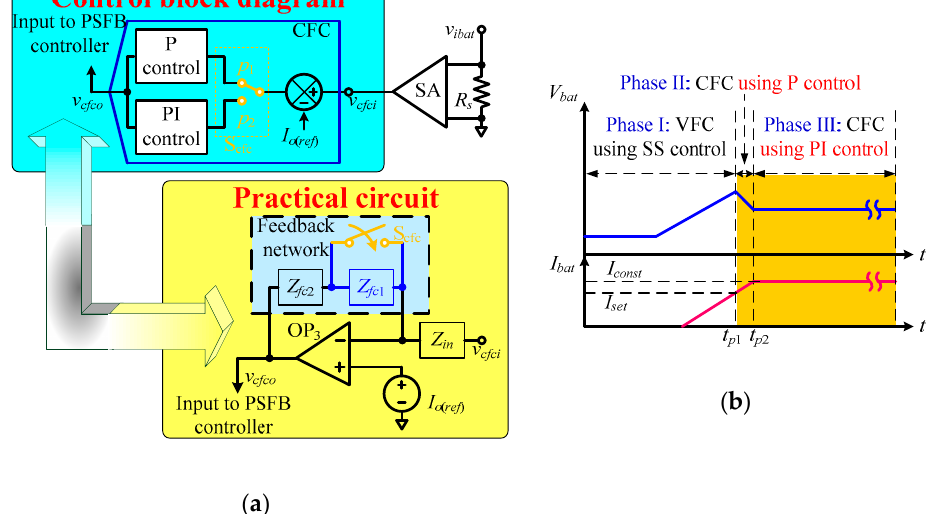
Figure 19. A novel PSPI control. ( a ) PSPI configuration diagram and practical circuit. ( b ) Phases I to III.